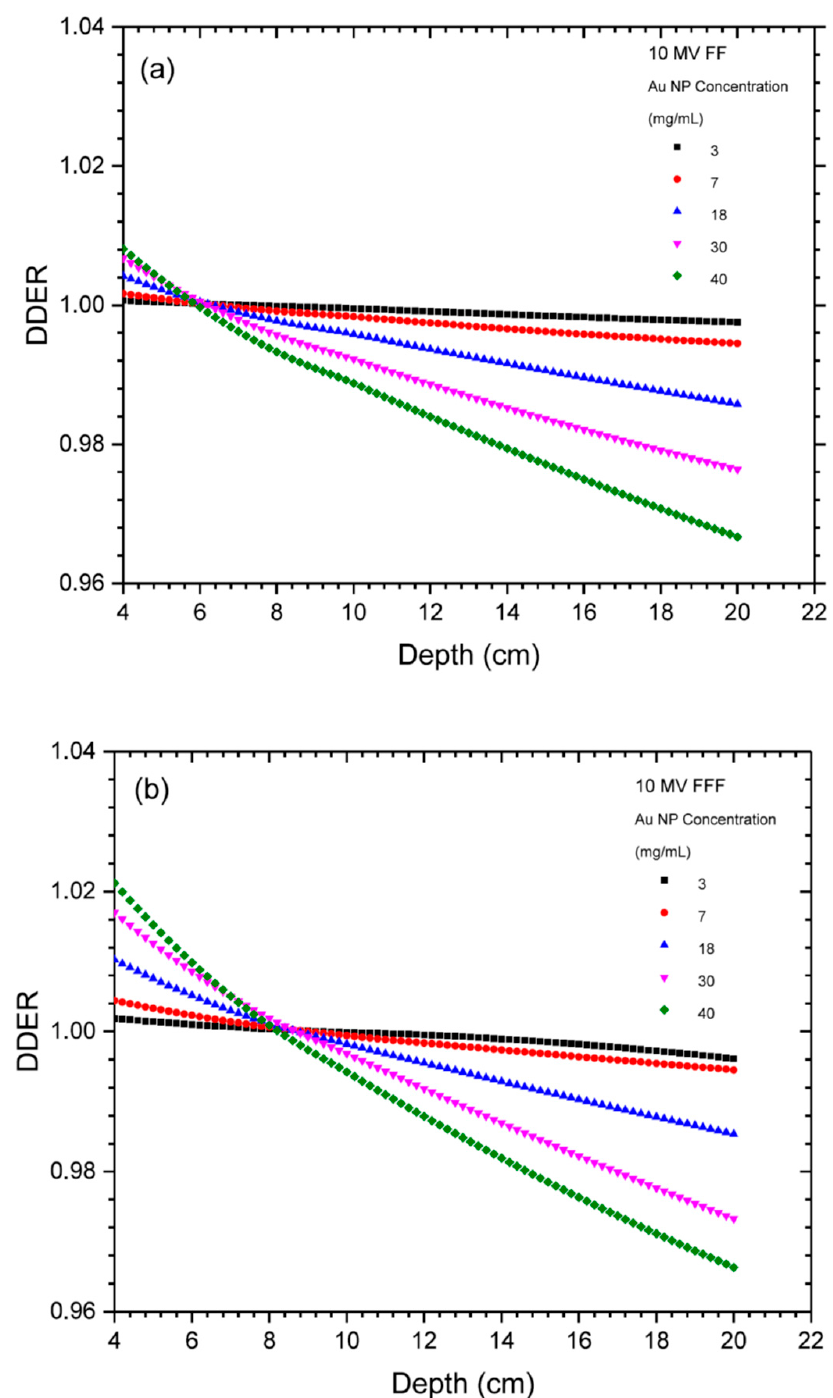
Figure 1. DDER vs. depth for different Au NP concentrations using the ( a ) 10 MV FF and ( b ) 10 MV FFF photon beams.